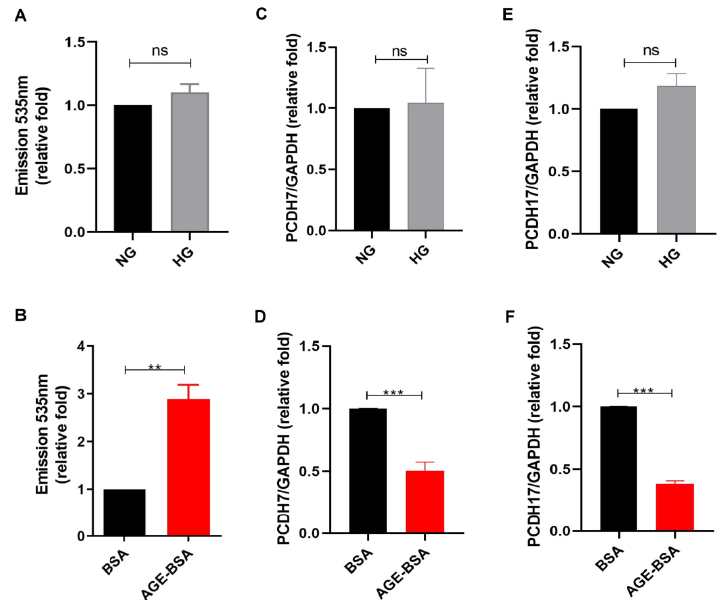
Figure 1. AGEs increased vascular permeability of GECs. ( A , B ) The permeability of HGECs was examined after treatment with NG (5.5 mM), HG (25 mM), BSA (300 µ g/ml), or AGE–BSA (300 µ g/ml) for 48 h ( n = 3) using fluorescein isothiocyanate (FITC)–dextran dye. ( C – F ) PCDH7 and PCDH17 mRNA were assessed in HGECs treated with NG, HG, BSA, or AGE–BSA for 24 h ( n = 3). ns = not significant, ** p < 0.01, *** p < 0.001 by Student’s t -test.